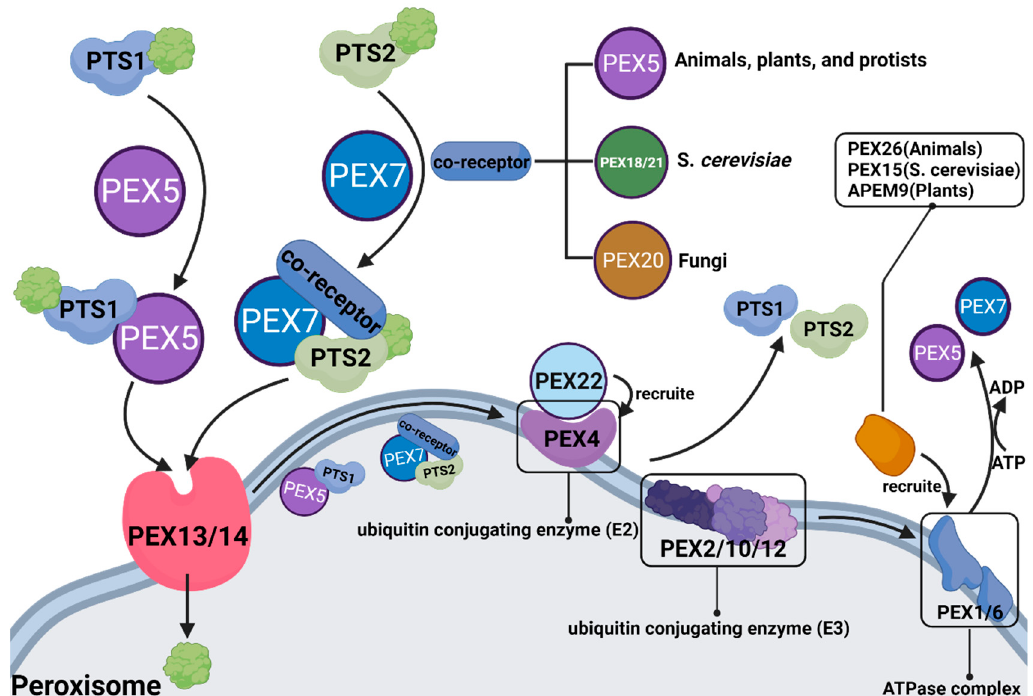
Figure 4. The role of different PEX proteins in peroxisomal β -oxidation.